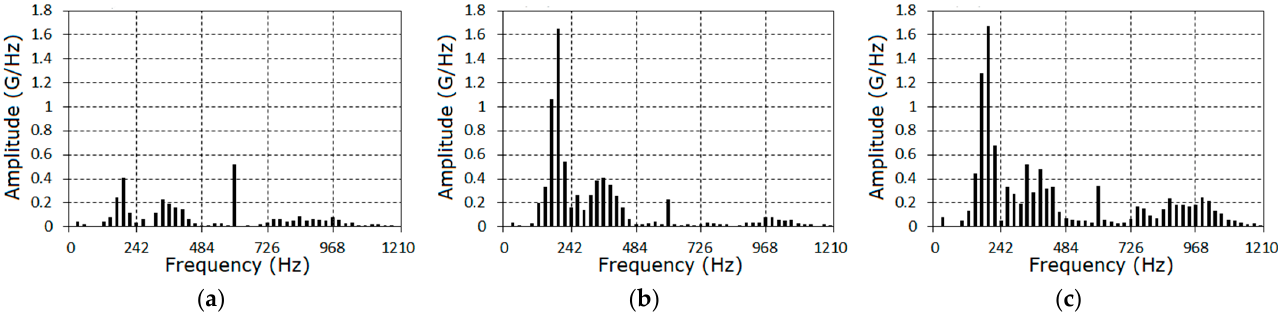
Figure 7. The amplitude spectra of the deterministic oscillations for the first ( a ), the second ( b ) and the third ( c ) stages.